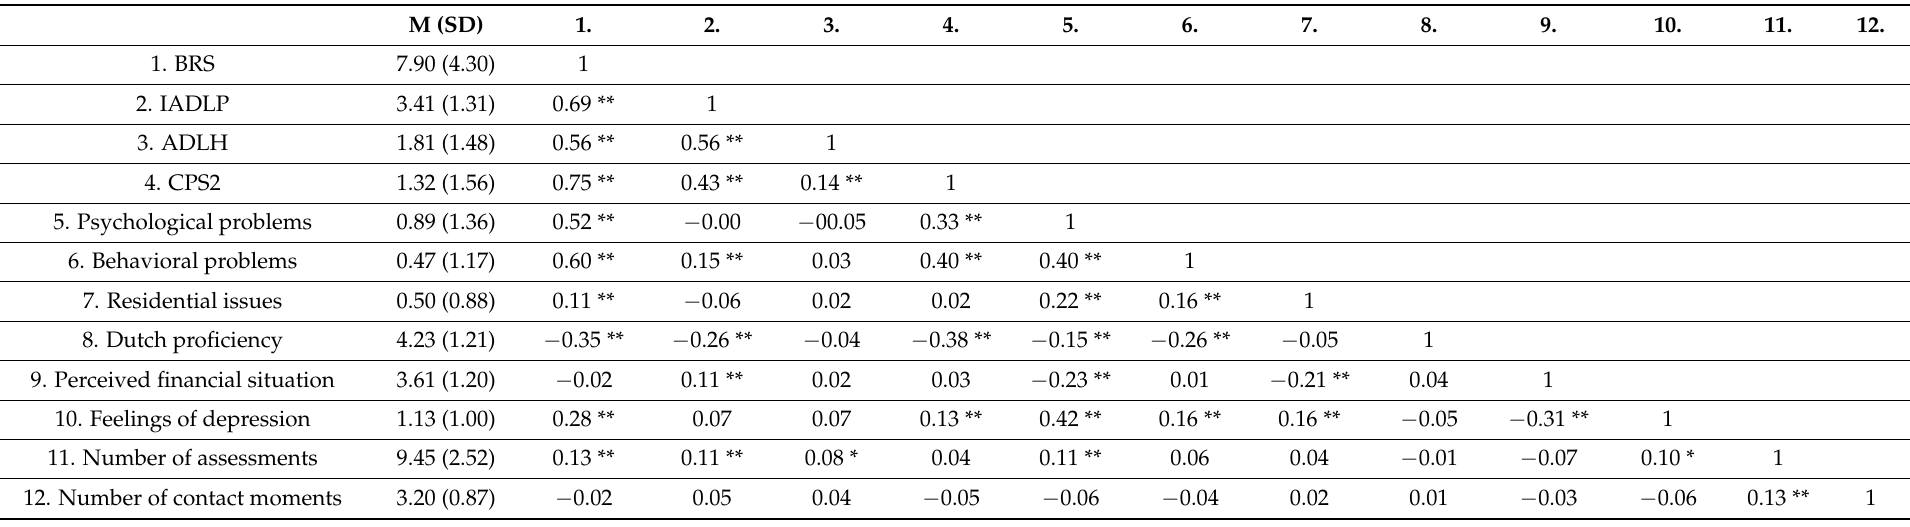
Table 2. Mean scores and Pearson correlations between dependent variables and key study